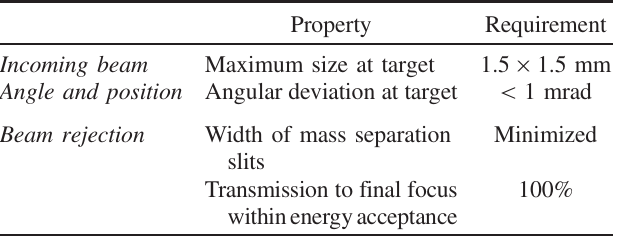
TABLE I. Beam requirements for optimal recoil separation in